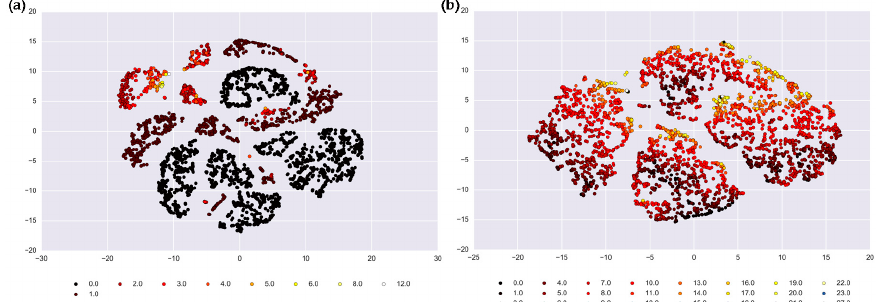
Figure 3. Results of t -SNE analysis depicted by the clustering distances in the vertical and horizontal axes for: ( a ) salmonellosis, A02.8, and ( b ) enteritis, A04.9 in Barnaul, Russia in 2004–2011. Colors represent health outcome counts from 0 to 12 for salmonellosis and 0 to 27 for enteritis.